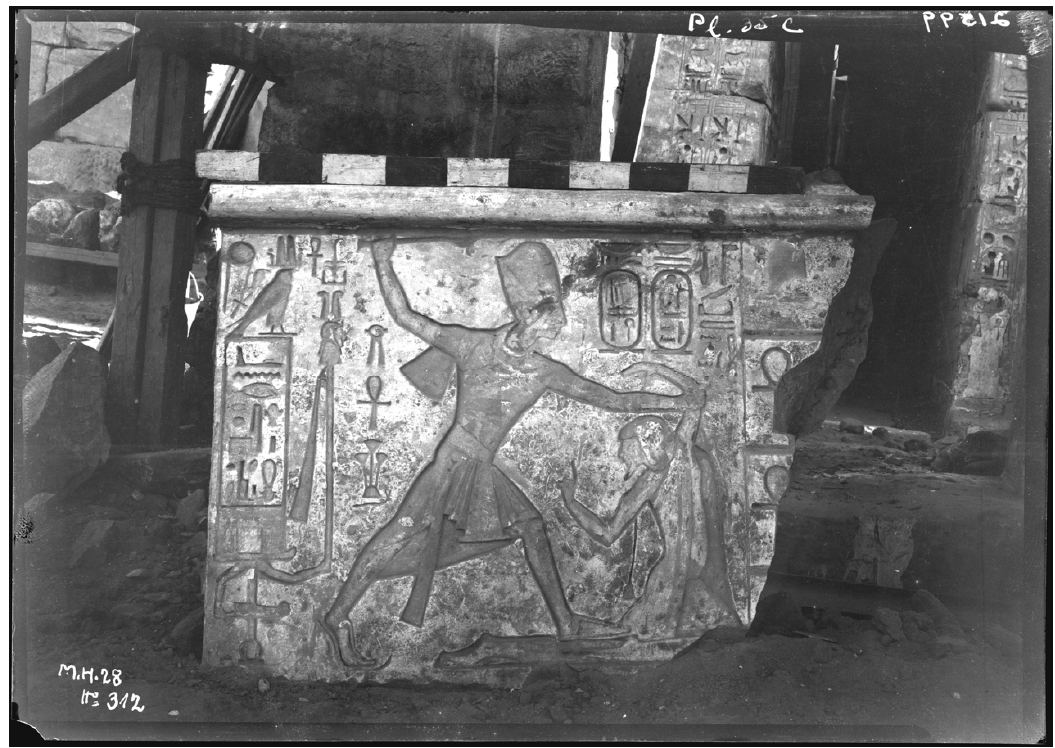
Figure 1. View of a building block with a relief of Ramesses III smiting a foreigner. Lintel from the north doorway in the harem court, Medinet Habu. OIM 829. Courtesy of the Oriental Institute, The University of Chicago.